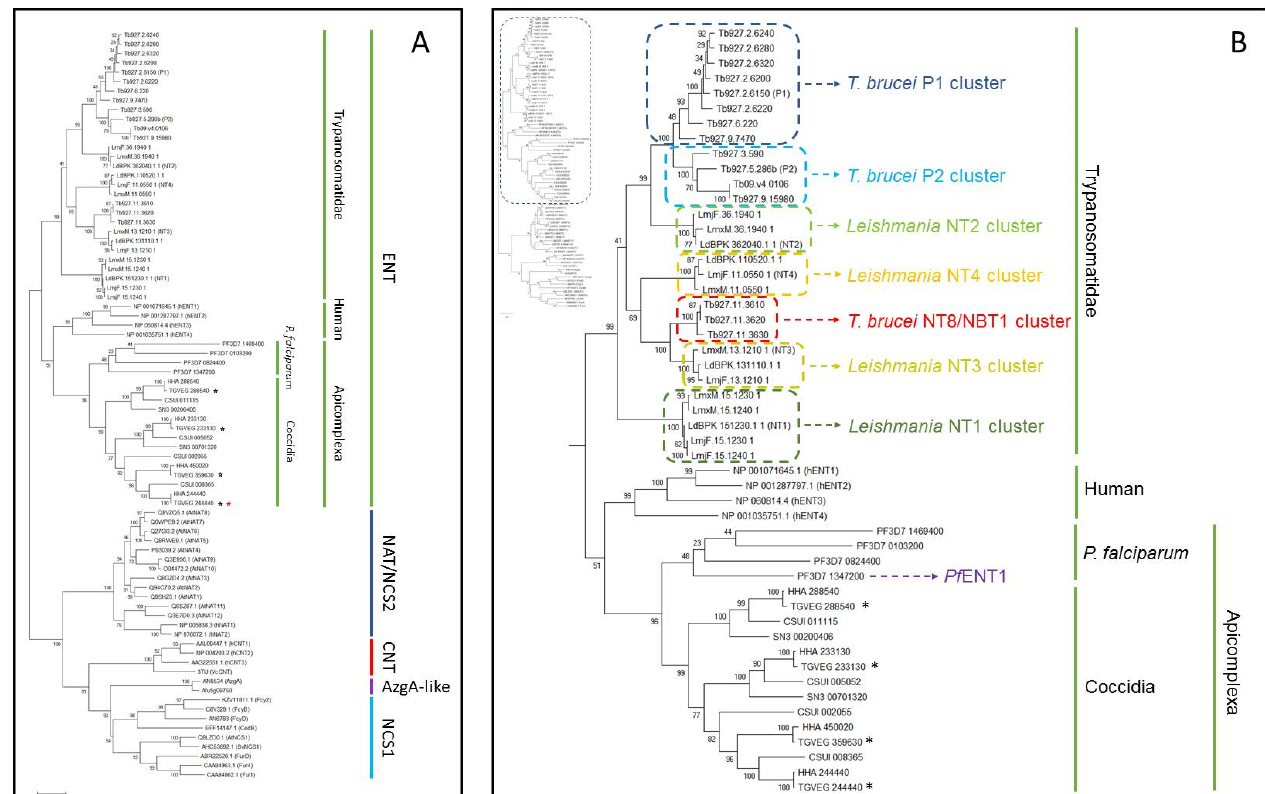
Figure 1. Phylogenetic tree of nucleoside and nucleobase transporters, constructed from a Clustal Omega amino acid multiple alignment by a Maximum Likelihood analysis in Mega-X (500 bootstraps). ( A ) Overview of division into different gene families. ( B ) Zoom-in on the ENT (SLC29) gene family, highlighting some well-characterised transporters. All sequences are listed in Supplemental Table S4. * highlights the position of the T. gondii ENT transporters.